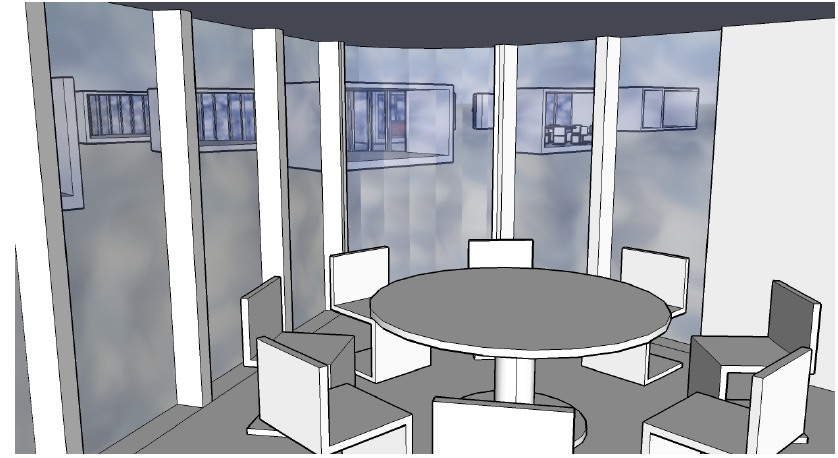
Figure 4: Extending floor area and improving view.